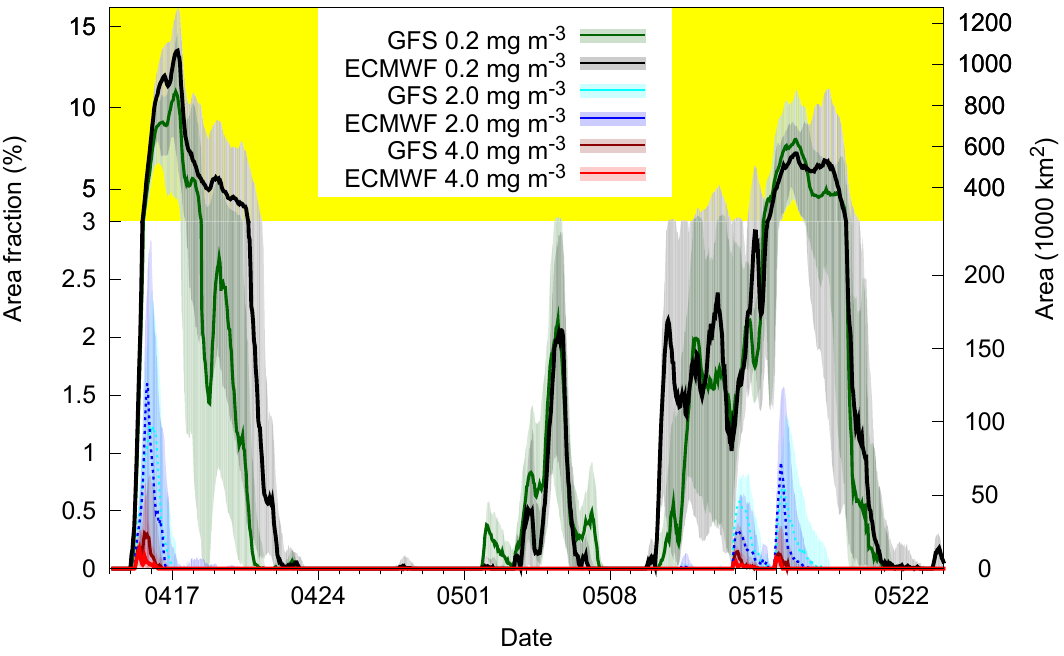
Fig. 13. Area of Europe affected by volcanic ash. Area in the domain 10 ◦ W–30 ◦ E and 36 ◦ N–60 ◦ N, expressed in relative (left axis) and absolute numbers (right axis) and shown as a function of time, where modeled ash was present somewhere between the surface and 13km altitude at concentrations higher than 0.2, 2 or 4mgm − 3 . These thresholds coincide with the European Commission (2010) ex post facto definition of “Normal” (below 0.2mgm − 3 ), “Enhanced Procedures” (0.2–2mgm − 3 , 2–4mgm − 3 ) and “No-Fly” (above 4mgm − 3 ) zones. Results are shown for model runs using two different meteorological data sets (ECMWF and GFS). Lines show reference model values and transparent areas indicate the span for a model uncertainty of ± 50%. Notice the change in ordinate scale at 3% (yellow area). For clarity, 2mgm − 3 lines are